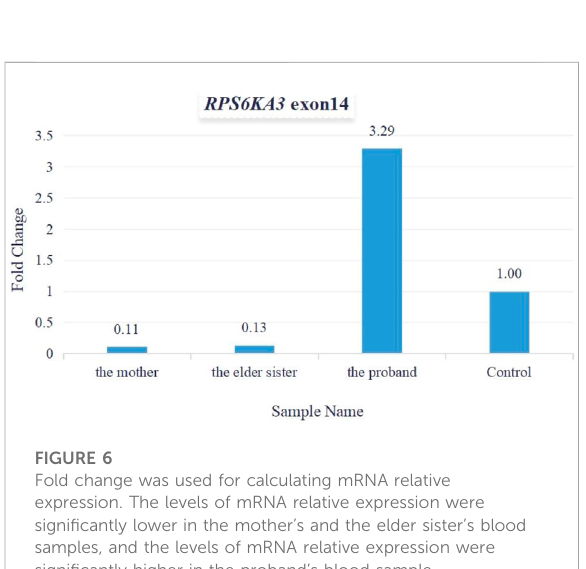
FIGURE 6 Fold change was used for calculating mRNA relative expression. The levels of mRNA relative expression were signi fi cantly lower in the mother ’ s and the elder sister ’ s blood samples, and the levels of mRNA relative expression were signi fi cantly higher in the proband ’ s blood